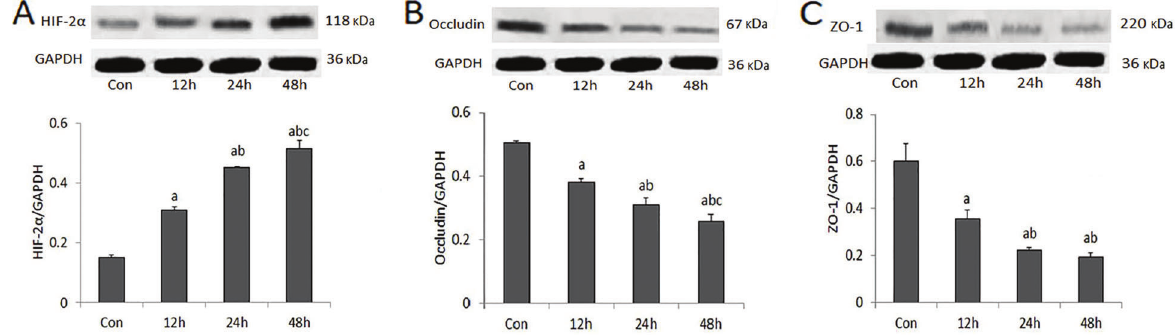
Figure 2. In fl uence of hypoxia on the expression of HIF-2 a , occludin, and ZO-1. A, with the elongation of hypoxia time, the expression of HIF-2 a gradually increased and B, occludin gradually decreased. C, Expression of ZO-1 also gradually decreased under hypoxia conditions, the differences being statistically signi fi cant, except for comparison between 24 and 48 h. Data are reported as means ± SD. a P o 0.01 compared with control group; b P o 0.01 compared with 12 h; c P o 0.01 compared with 24 h (ANOVA). Con: control group.